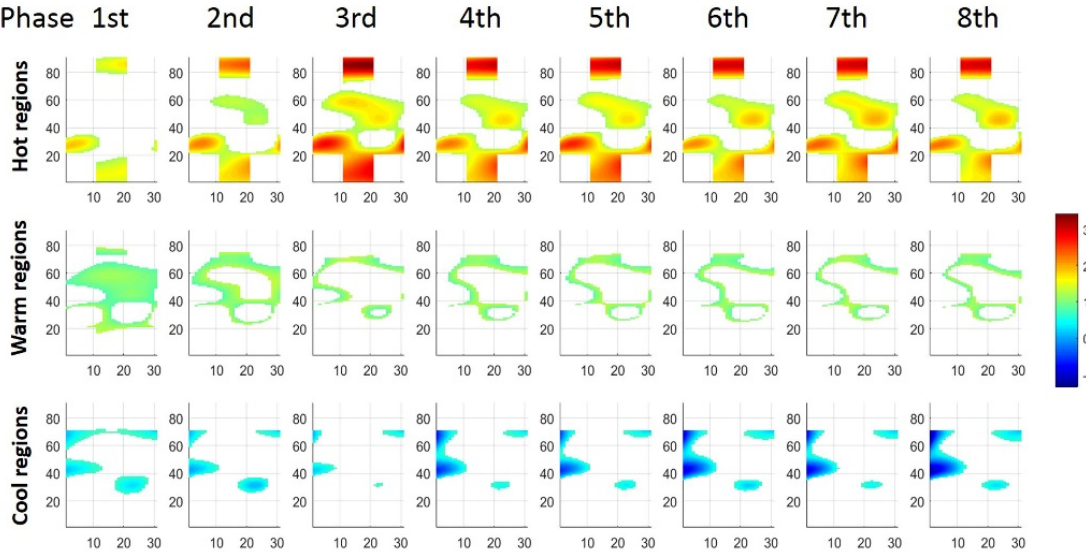
Figure 4. Hot regions, warm regions and cool regions at 8 phases during sustained index extension ( same subject as Figure 3).